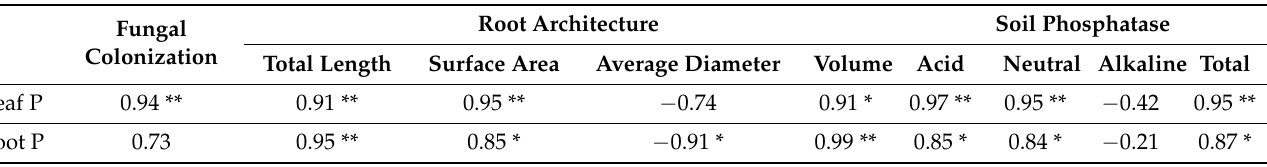
Table 4. Correlationships between leaf and root P concentrations and root fungal colonization rate, root morphological variables, and soil phosphatase activities ( n = 24).